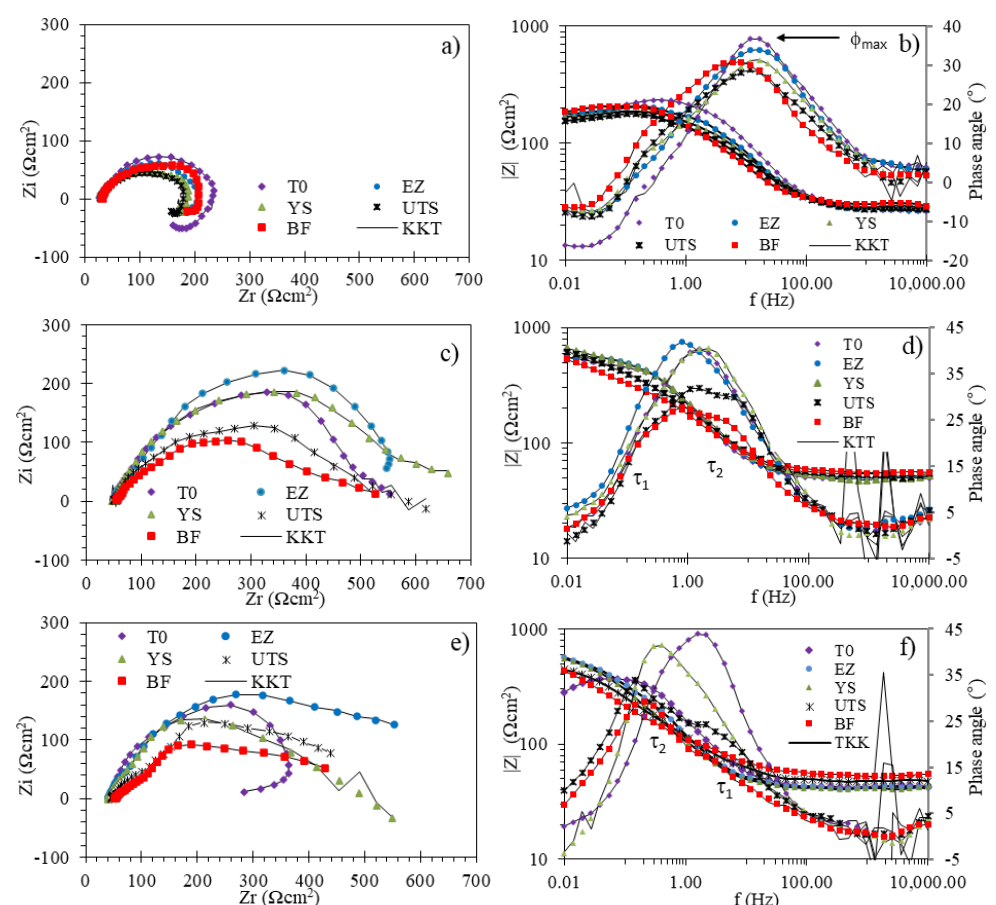
Figure 5. Nyquist ( a , c , e ) and Bode ( b , d , f ) plots for X70 steel in NS4 solution at different pH during SSRT test: pH 3 ( a , b ), pH 8 ( c , d ) and pH10 ( e , f ).